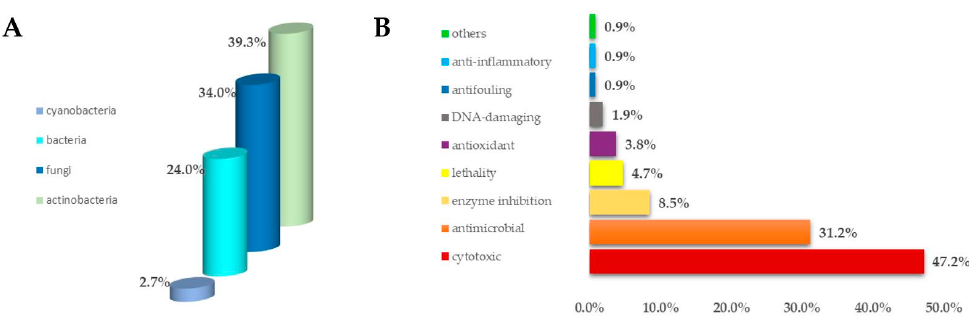
Figure 1. ( A ) Percentage distribution of microorganisms paired to ascidians from which marine metabolites derive; ( B ) bioactivities of secondary metabolites isolated from ascidian-associated microorganisms described as percentage distribution.